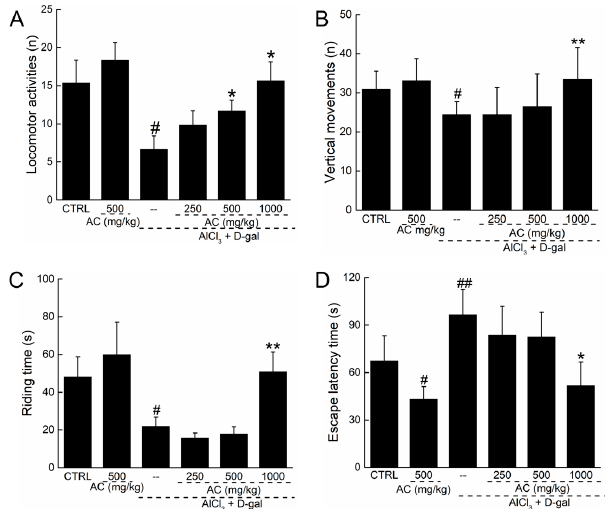
Figure 4. AC improves AD-like behaviors in D -gal and AlCl 3 development AD mice. Compared with non-treated AD mice, 28-day AC administration enhanced horizontal movements( A ) and vertical movements ( B ) in locomotor activity test; ( C ) enhanced the remaining time in rotating test; ( D ) reduced the escape latency time in WMT. Data expressed as mean ± S.E.M. ( n = 12). # p < 0.05 and ## p < 0.01 vs. control mice, * p < 0.05 and ** p < 0.01 vs. AD mice.